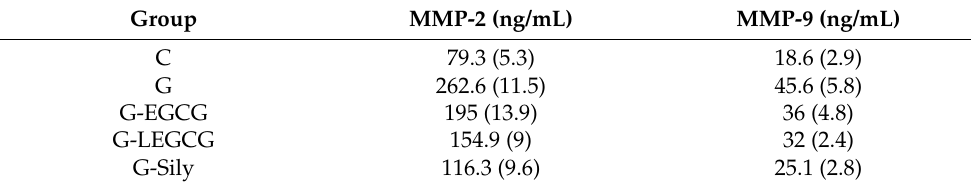
Table 5. Serum levels of evaluated matrix metalloproteinases (MMPs) by groups after gentamicin administration: comparative effect of EGCG, LEGCG, and silymarin.